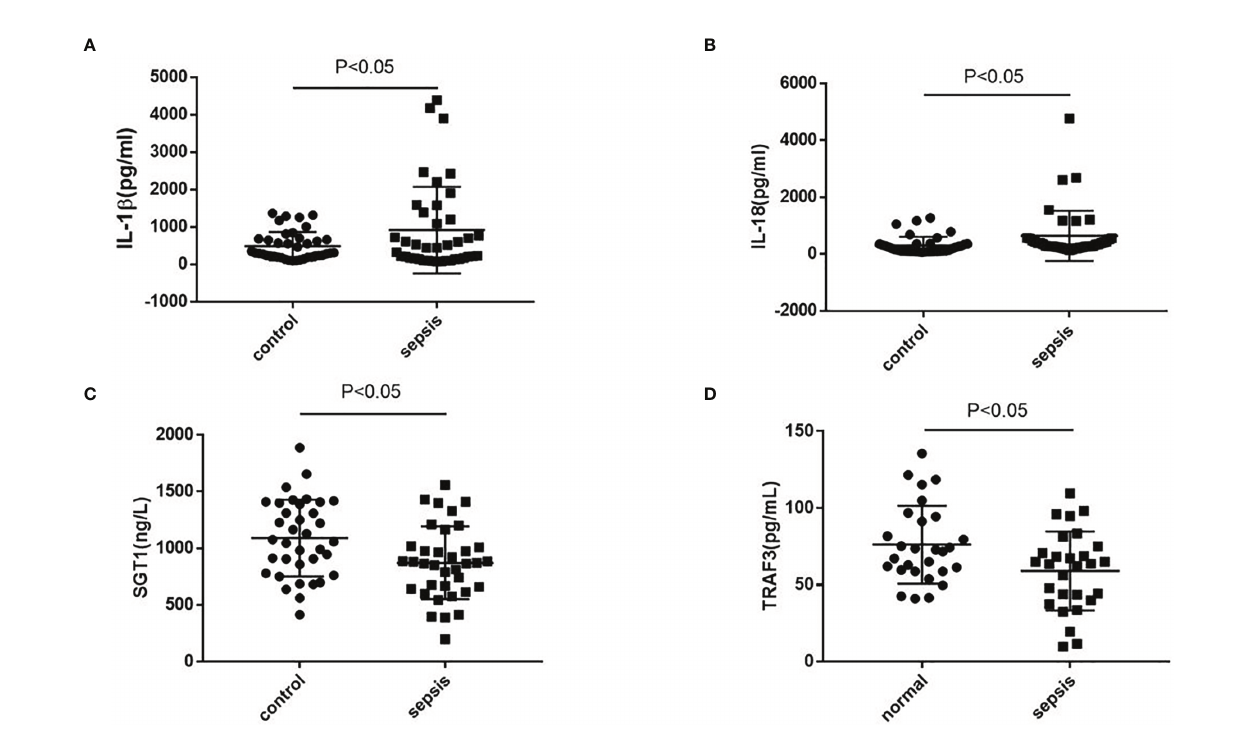
FIGURE 7 | The expression of NLRP3 in fl ammasome-related genes in serum of patients with clinical sepsis. (A – D) The expression of IL-1 b , IL-18, TRAF3, and SGT1 in serum of patients with clinical sepsis was detected by ELISA. Data are representative or means (SD) of at least three independent experiments. Statistical analyses were determined using a Student ’ s t